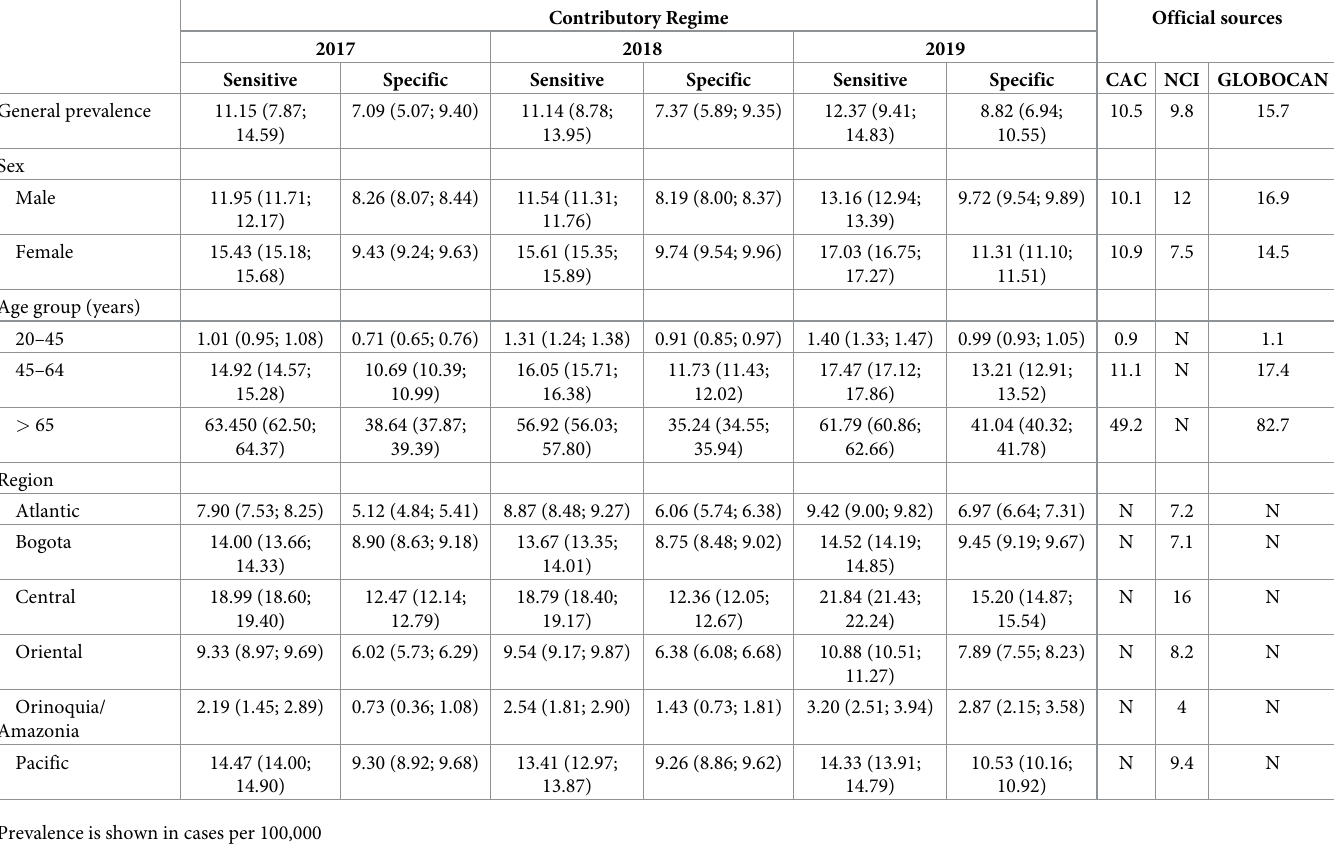
Table 1. Comparison between the prevalence rates identified in this study versus official aggregated data sources for 2017, 2018 and 2019 in the contributory